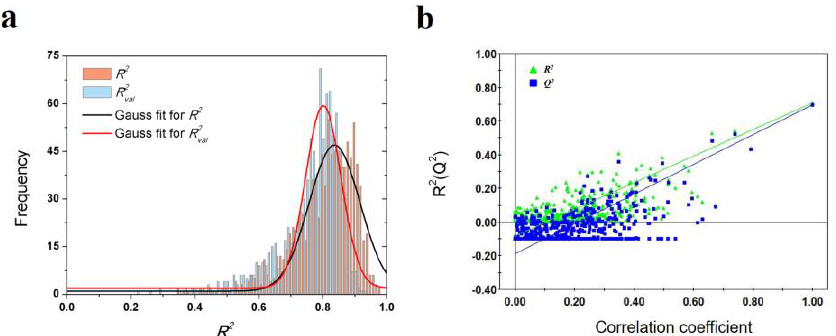
Figure 6. Validations of the optimal PLS model: ( a ) frequency distribution of R 2 and R 2 val in 1000-times